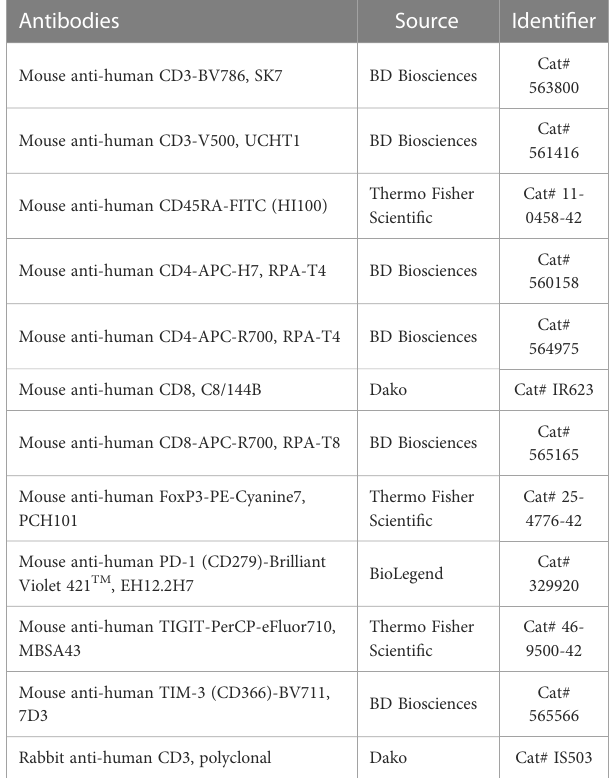
TABLE 2 List of